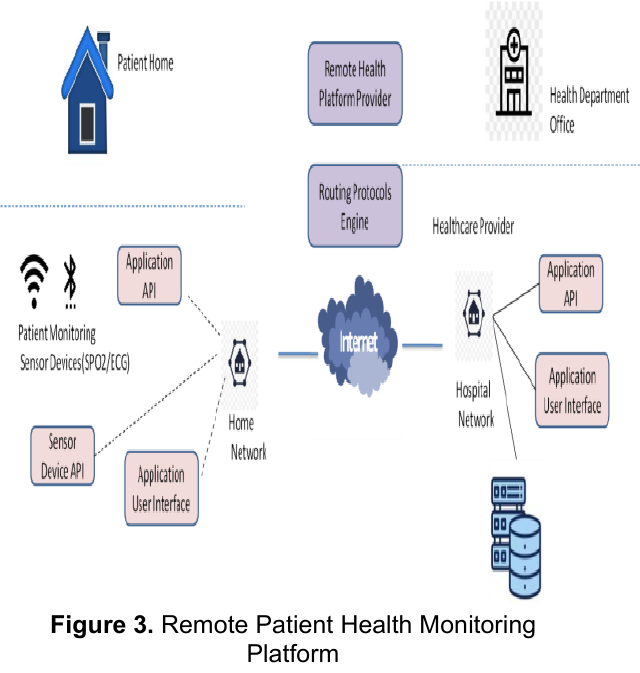
Figure 3. Remote Patient Health Monitoring Platform